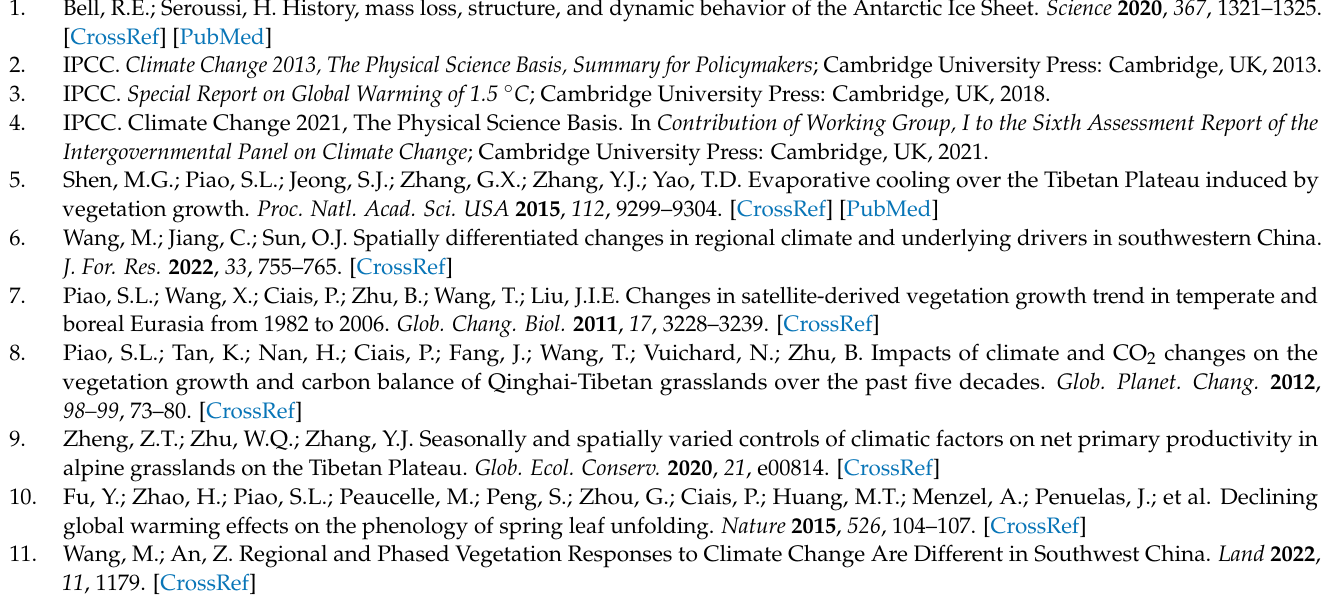
Figure A1. ( a ) The actual range of the significant moderating effect of precipitation on the relationship between temperature and NDVI (k NDVI–T ), and ( b ) the actual range of the significant moderating effect of temperature on the relationship between precipitation and NDVI (k NDVI – P ). Note: “*” and “Ns” indicate the significance levels of P < 0.05 and P > 0.05, respectively. If the significance is Ns, the interval length is not shown in the figure and is only represented by the symbol “growth stages +Ns”; “+”and “−” indicate that the temperature (precipitation) had a positive or negative regulating effect on k NDVI – P (k NDVI – T ), respectively.